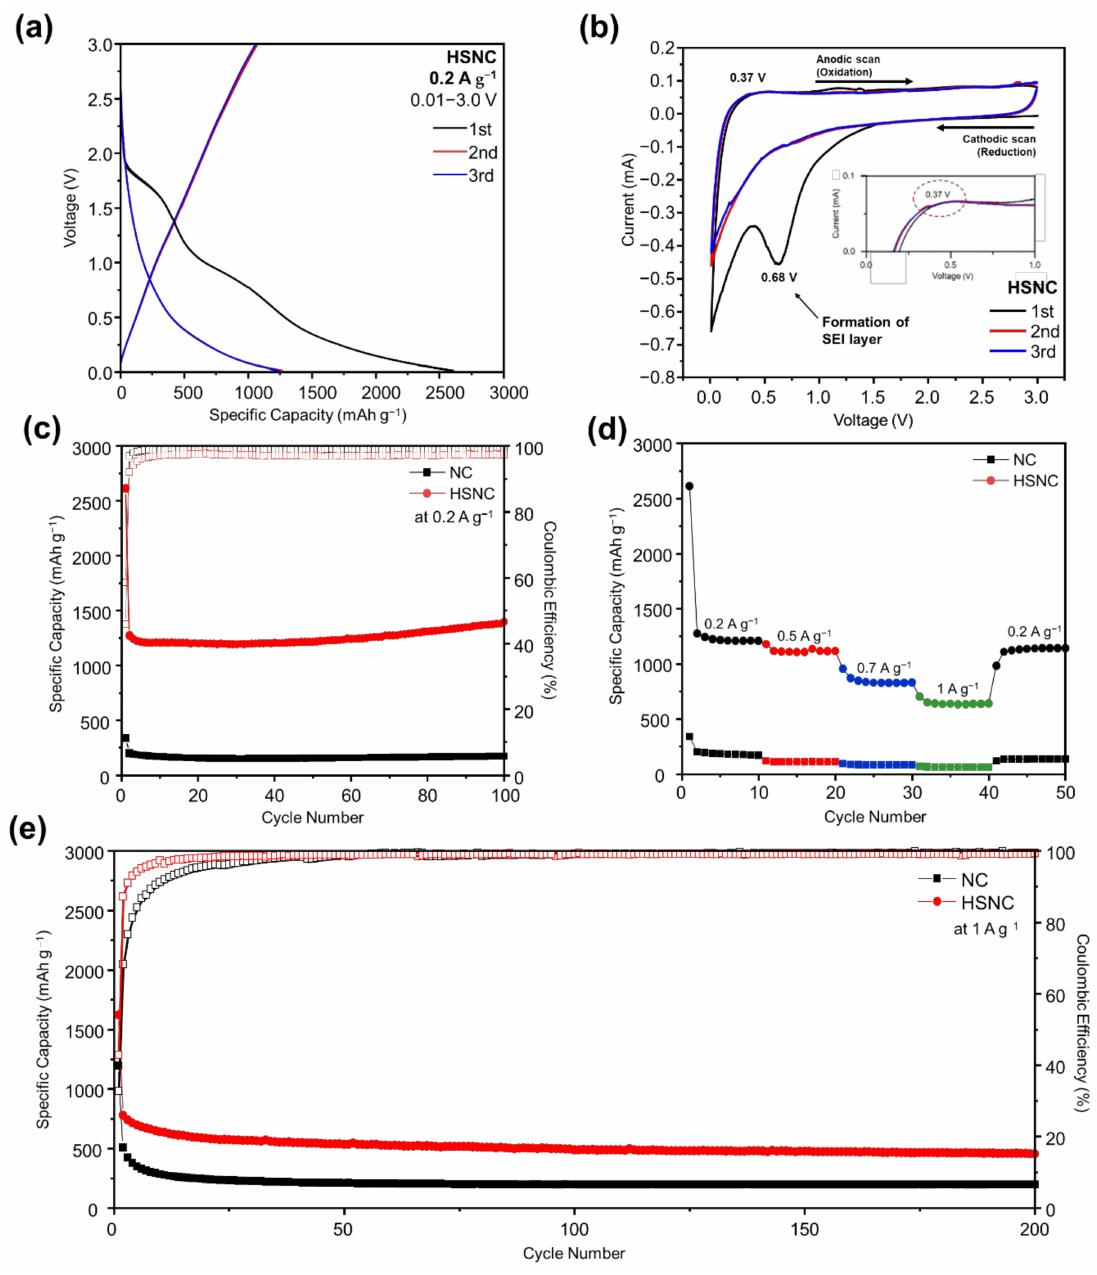
Figure 6. ( a ) Discharge–charge voltage profiles during the first three cycles at 0.2 A · g − 1 ; ( b ) CV curve at a scan rate of 0.01 mV · s − 1 from the HSNC sample in the voltage range of 0.01–3.0 V; ( c ) cycle performance at a current density of 0.2 A · g − 1 ; ( d ) rate performance at various current densities; and ( e ) high rate-cycling performance at 1 A · g − 1 for HSNC and